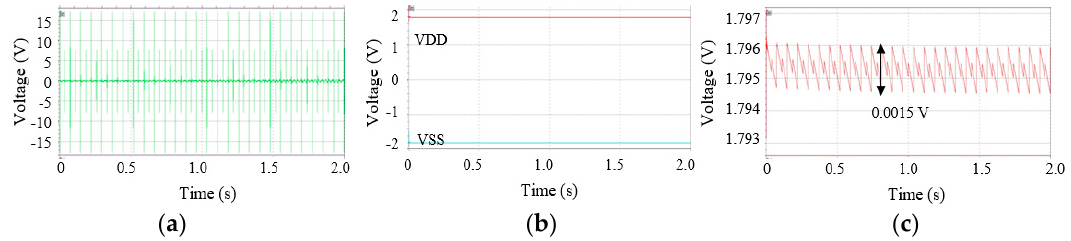
Figure 7. Simulation results in case of a regular vibration, ( a ) harvester voltage outputs, ( b ) a VDD and a negative power supply voltage (VSS) for the neural recording circuits, and ( c ) zoomed-in VDD from (b).